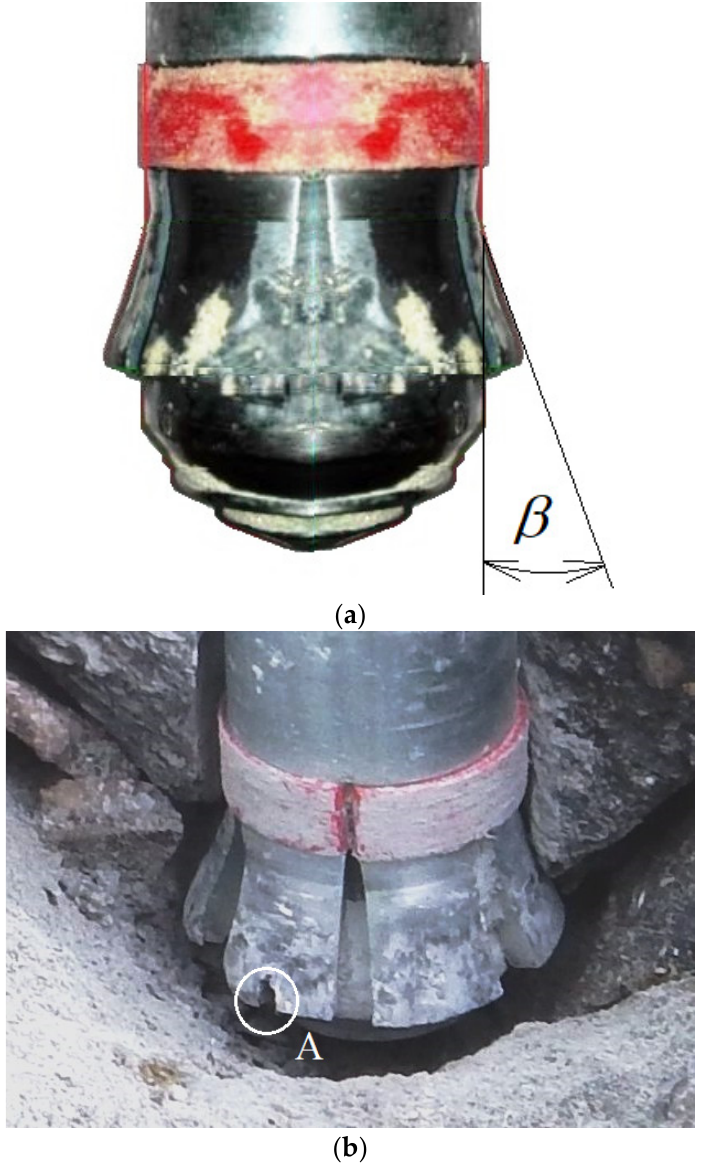
Figure 11. Symptoms of wear of the anchor head undercutting elements: ( a ) decrease in the angle of the head cone β and ( b ) reduction in the head angle due to removal of the tungsten carbide plate reinforcing the undercutting element—detail “A”.